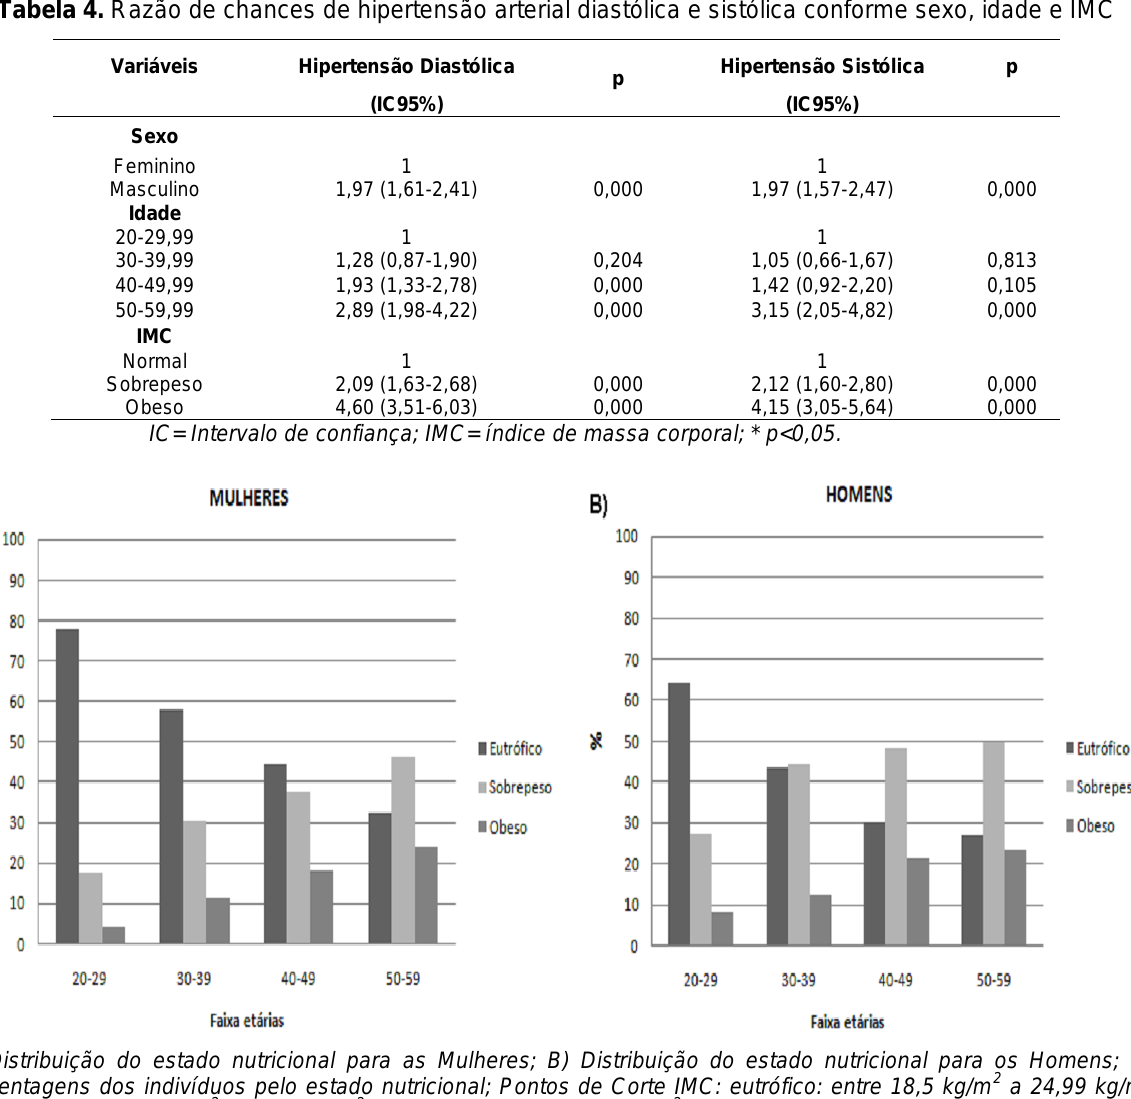
Figura 1. Distribuição (%) dos pontos de corte do IMC de acordo com faixas etárias em ambos os